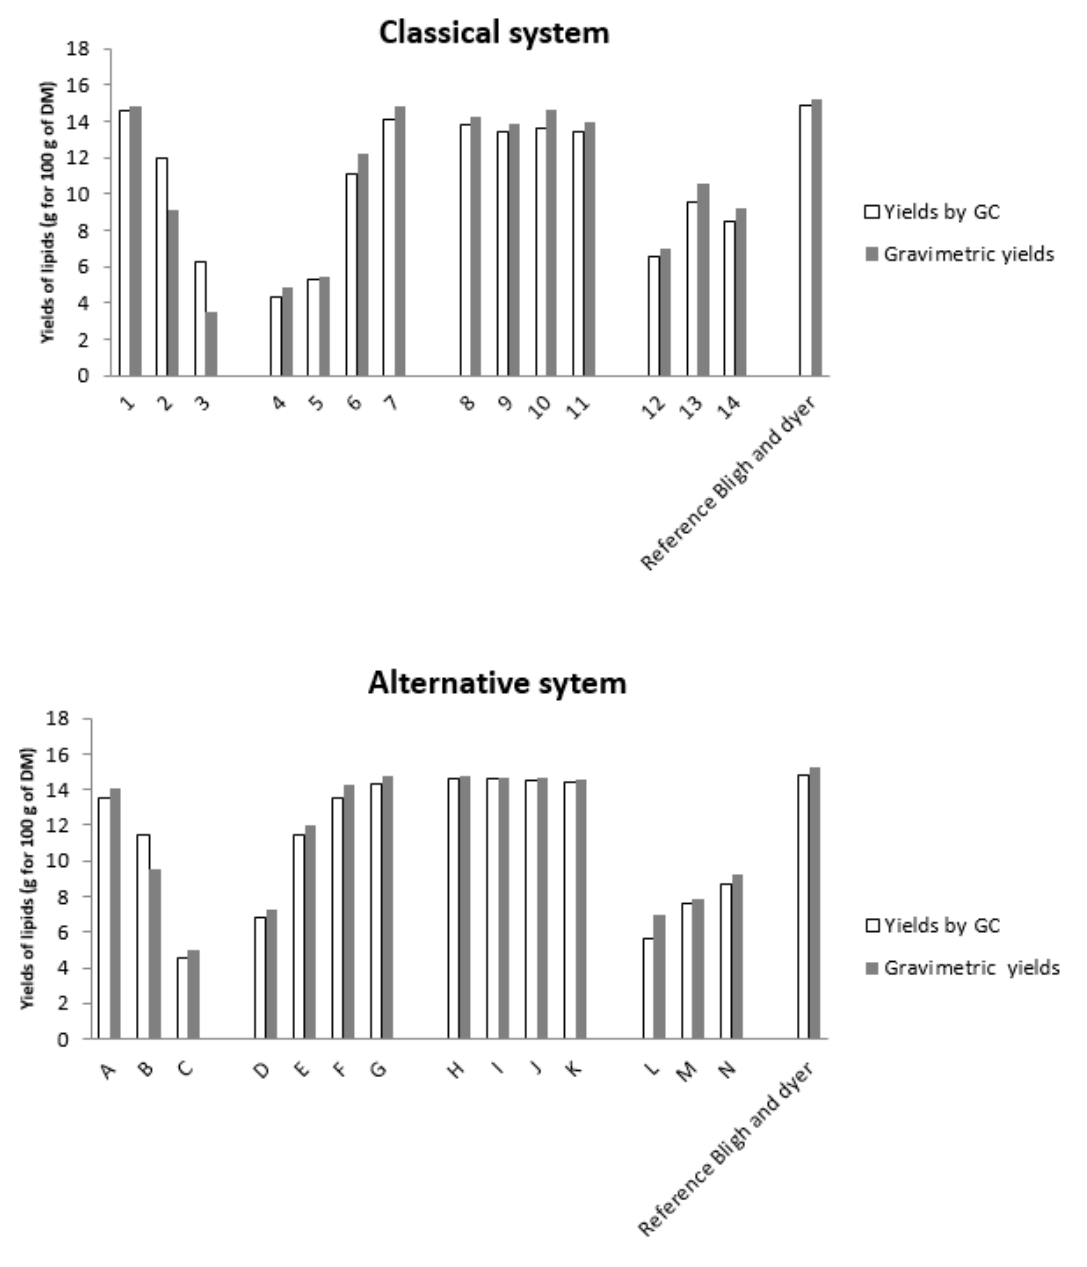
Figure 2. Extraction yields (g for 100 g of dry matter (DM)): Results of different extractions realized with the chloroform–methanol–water system and with the ethyl acetate–ethanol–water system, given by the gravimetric method and gas chromatography compared to the Bligh and Dyer reference method (1959).